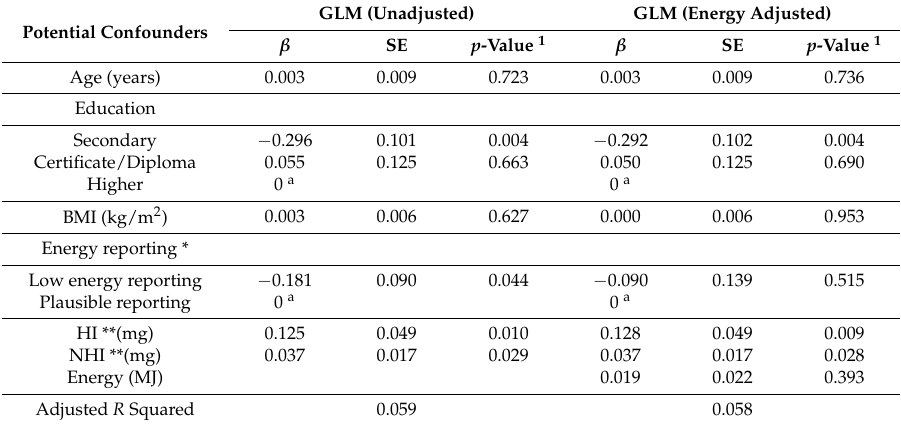
Table 3. General linear model (GLM) for SF, predictors with and without